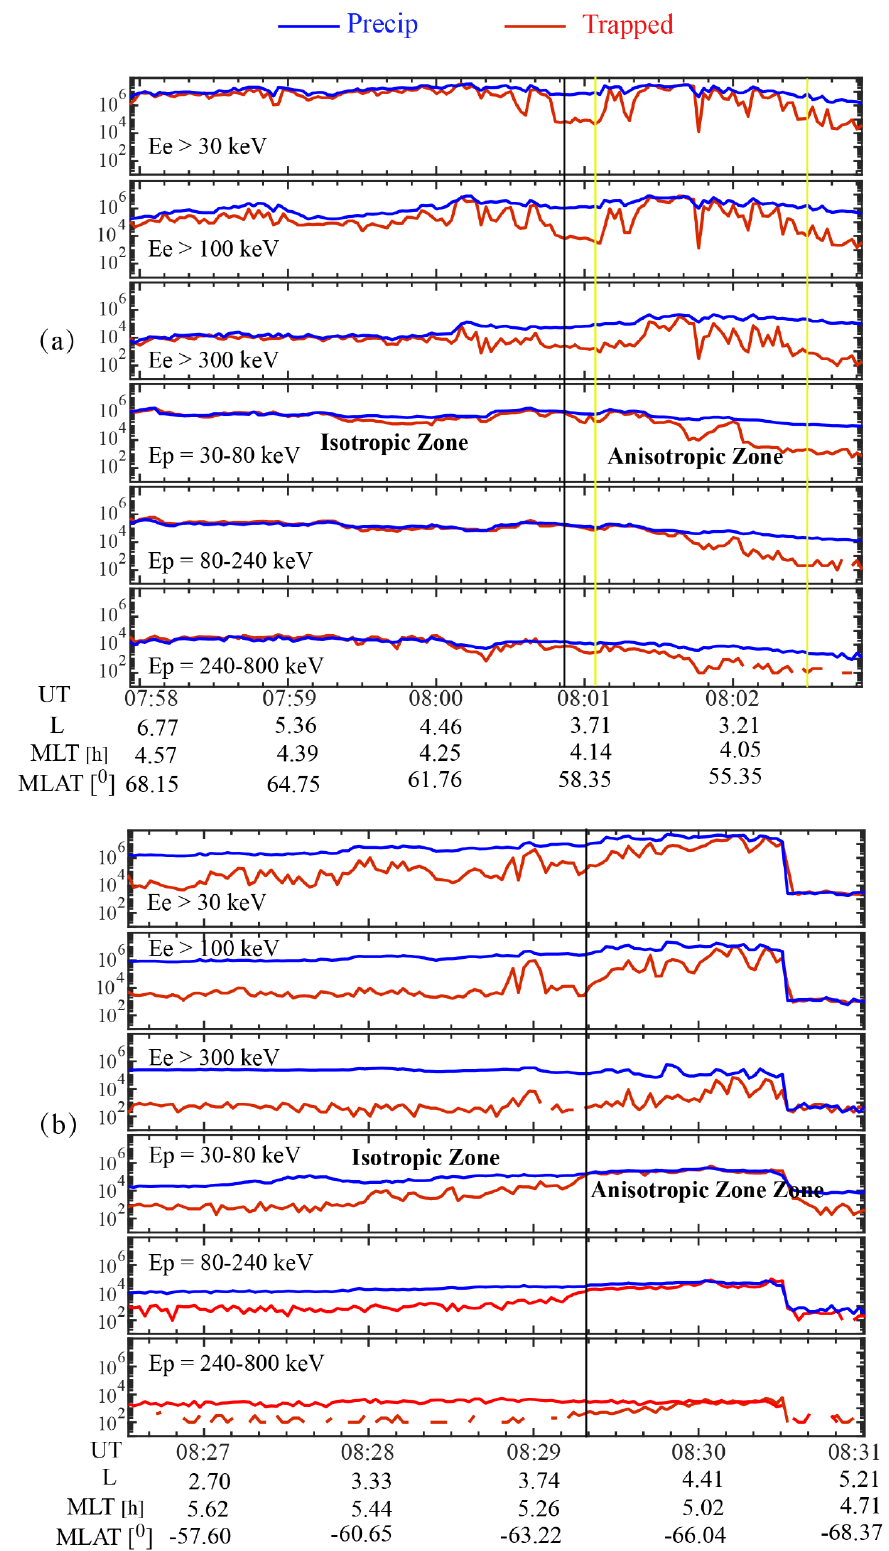
Figure 4. ( a ) The trapped (red) and precipitating (blue) flux of the energetic electrons and protons in different energy channels observed by the NOAA 16 satellite. The precipitating electron region in the anisotropic region is denoted by two vertical yellow lines. The proton isotropic line is denoted by the black line ( L ~ 3.88). ( b ) The format is same as ( a ) which is observed by NOAA 15. The proton isotropic boundary is also denoted by vertical lines ( L ~